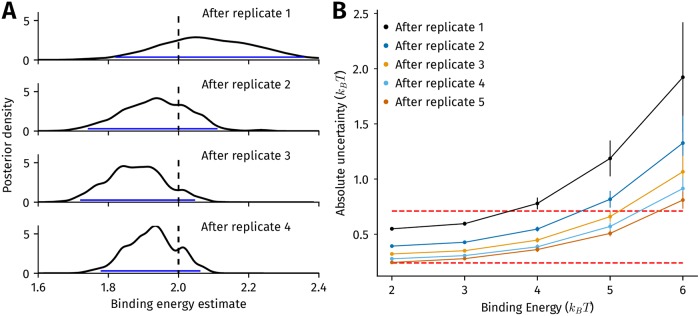
Impact of multiple biological replicates on uncertainty in binding energy estimates.(A) Posterior estimate of the binding energy at a single genomic locus after 1-4 replicates. The true binding energy of the locus is 2kB
T, indicated by the vertical dashed line. Four replicates of ChIP-seq were simulated, with the posterior density after each replicate, with the prior distribution set to be the default binding energy distribution employed in all our simulations (Methods). The blue lines indicate the absolute uncertainty of the binding energy estimate, which we define as the 95% Bayesian credible interval of the binding energy. This is calculated as the difference between the 2.5th and 97.5th quantiles of the posterior density. (B) The reduction in absolute uncertainty of posterior binding energy estimates of five locations, each with a different binding energy, after five replicates of ChIP-seq. The error bars are the standard deviation in estimates of the absolute uncertainty calculated after 100 trials; the filled circles represent the mean absolute uncertainty from these trials. The dashed red lines represent the values of absolute uncertainty required to distinguish between binding sites sequences that are a single mutation apart at least 50% of the time (upper,0.71kB
T) and at least 75% of the time (lower,0.24kB
T).